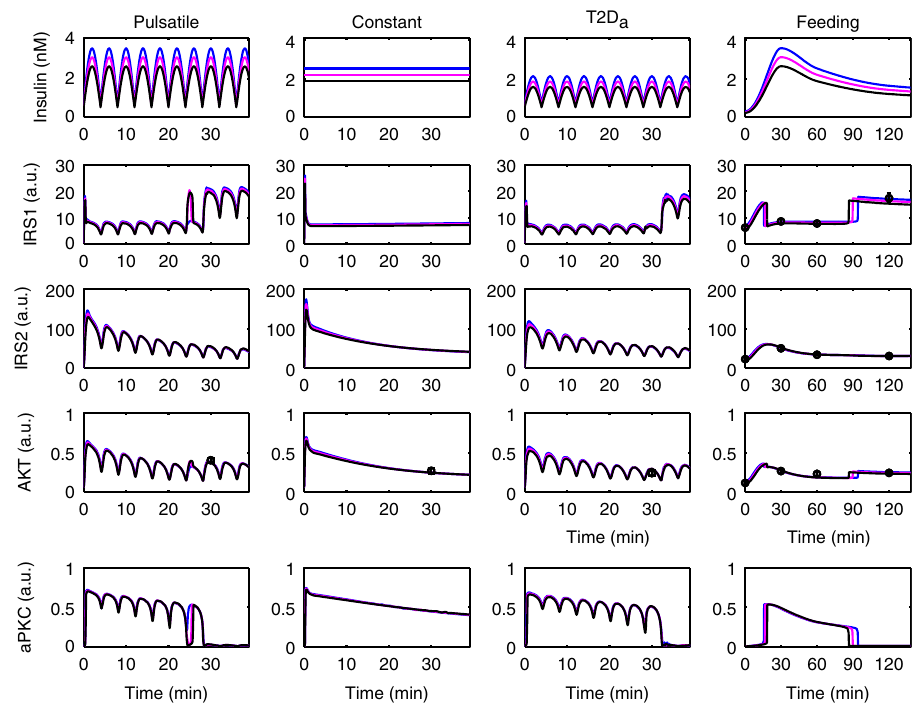
Fig. 4 Response of the model to three doses of insulin. The activities of the signaling molecules are plotted with arbitrary unit (a.u.). Each column corresponds to one speci fi c experimental set-up (see text). The best fi t in Fig. 2 is shown in magenta which de fi nes a reference amount of insulin. Using 85 and 115% of this insulin is shown in black and blue, respectively. The timing of aPKC switch-off and IRS1-AKT rebound is sensitive to the insulin level, while the activation level is not. See Supplementary Fig. 4 for similar results based on other parameter